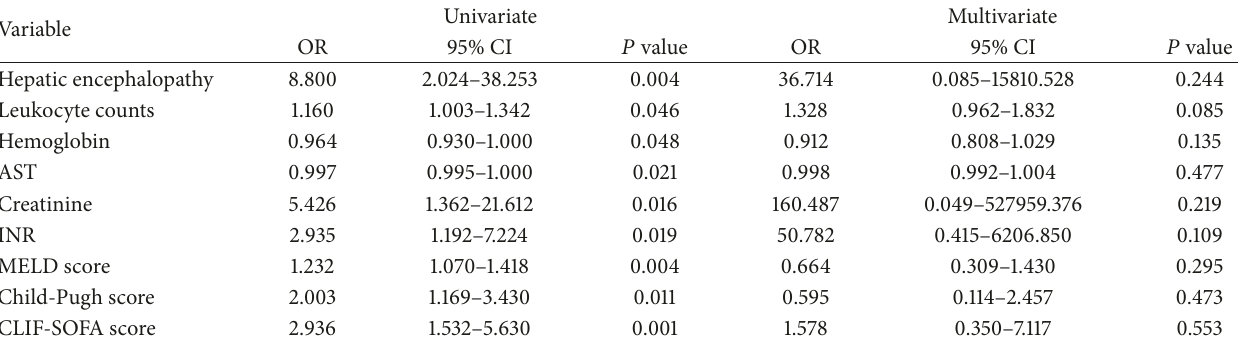
Table 3: Significant univariate and multivariate logistic regression analyses of 90-day transplant-free